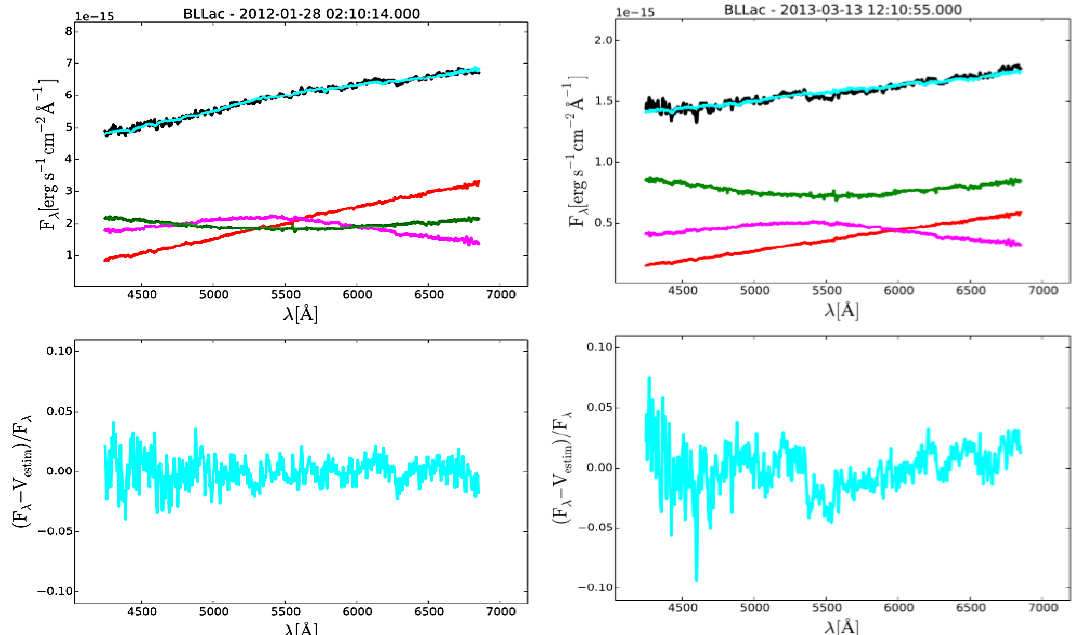
Figure 7. Non-Negative Matrix Factorization (NMF) decomposition of BL Lac spectra. Top panels show the decomposition of an observed spectrum (black), as the sum (cyan) of several components, shown with its corresponding scaling factor (red, magenta and green). Bottom panels show residuals. Right and left panels correspond to low and high flux states,